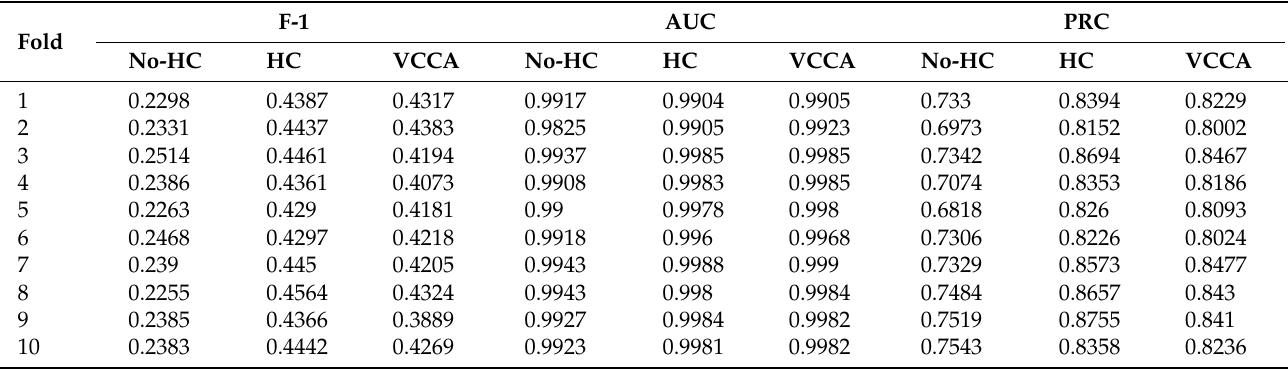
Table 15. The Mean of Metrics from Dataset 3.